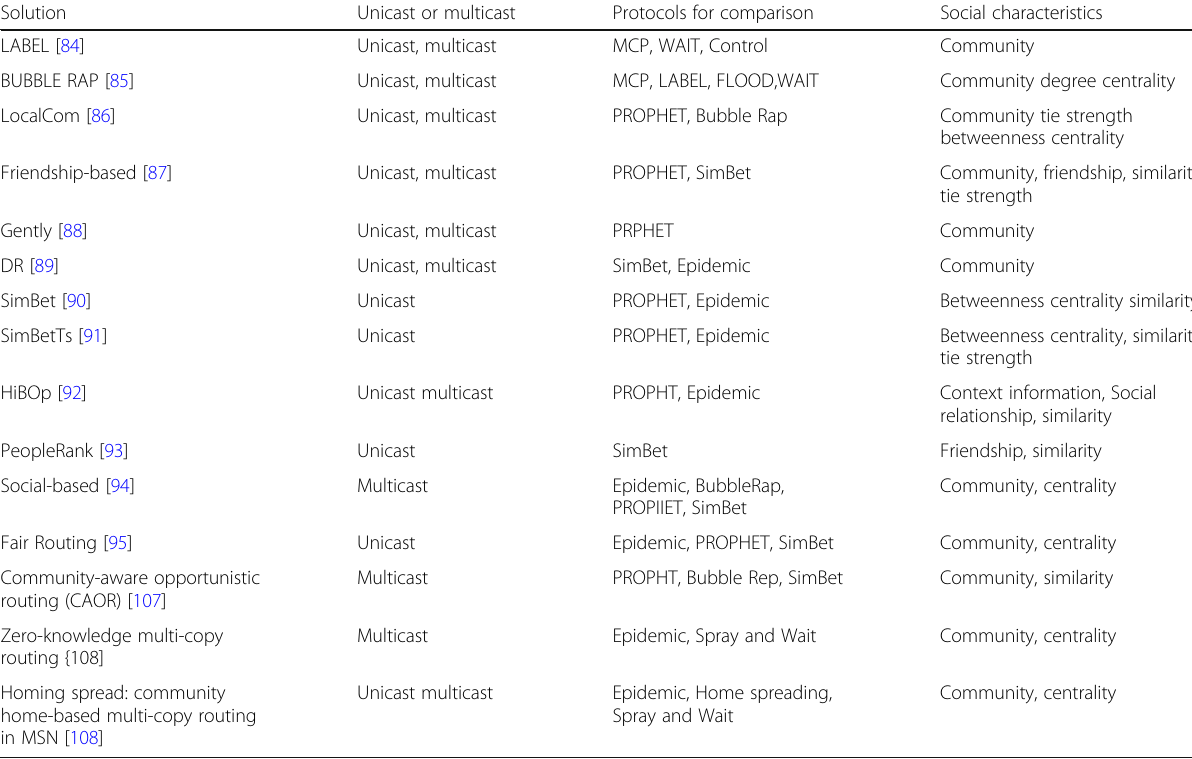
Table 5 Solution, protocol compare, and social characteristics